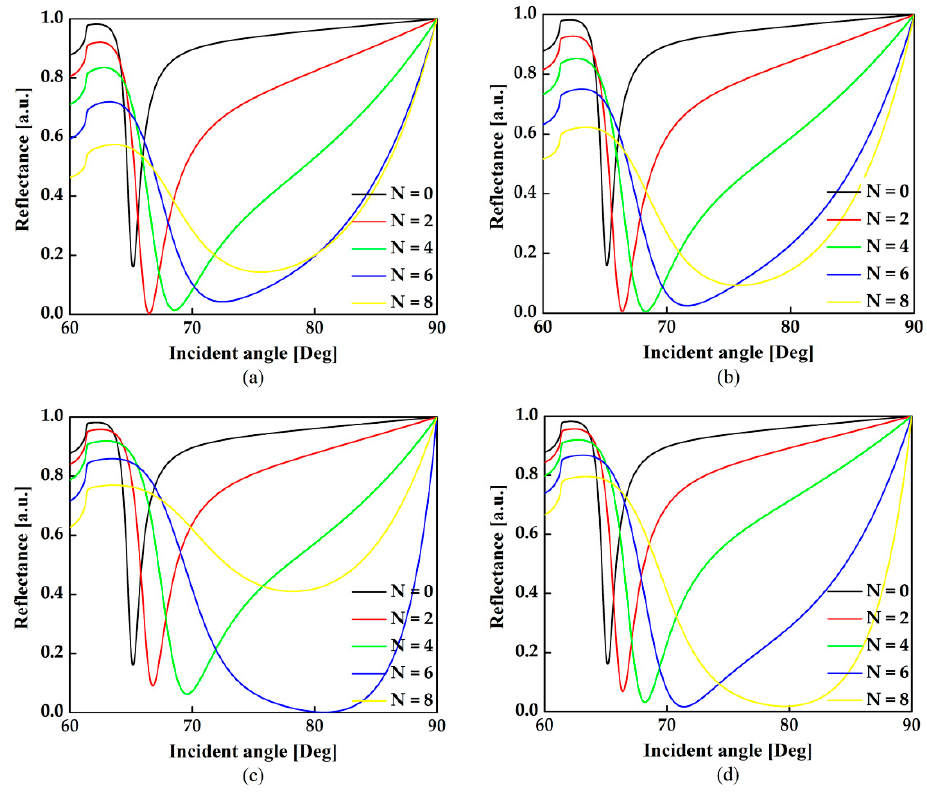
Figure 4. Variation of the reflectance respect to the different number of ( a ) MoS 2 , ( b ) WS 2 , ( c ) MoSe 2 and ( d ) WSe 2 layers with the thickness of Al thin film is fixed at 30 nm and the refractive index of sensing medium ∆ n = 1.3300.